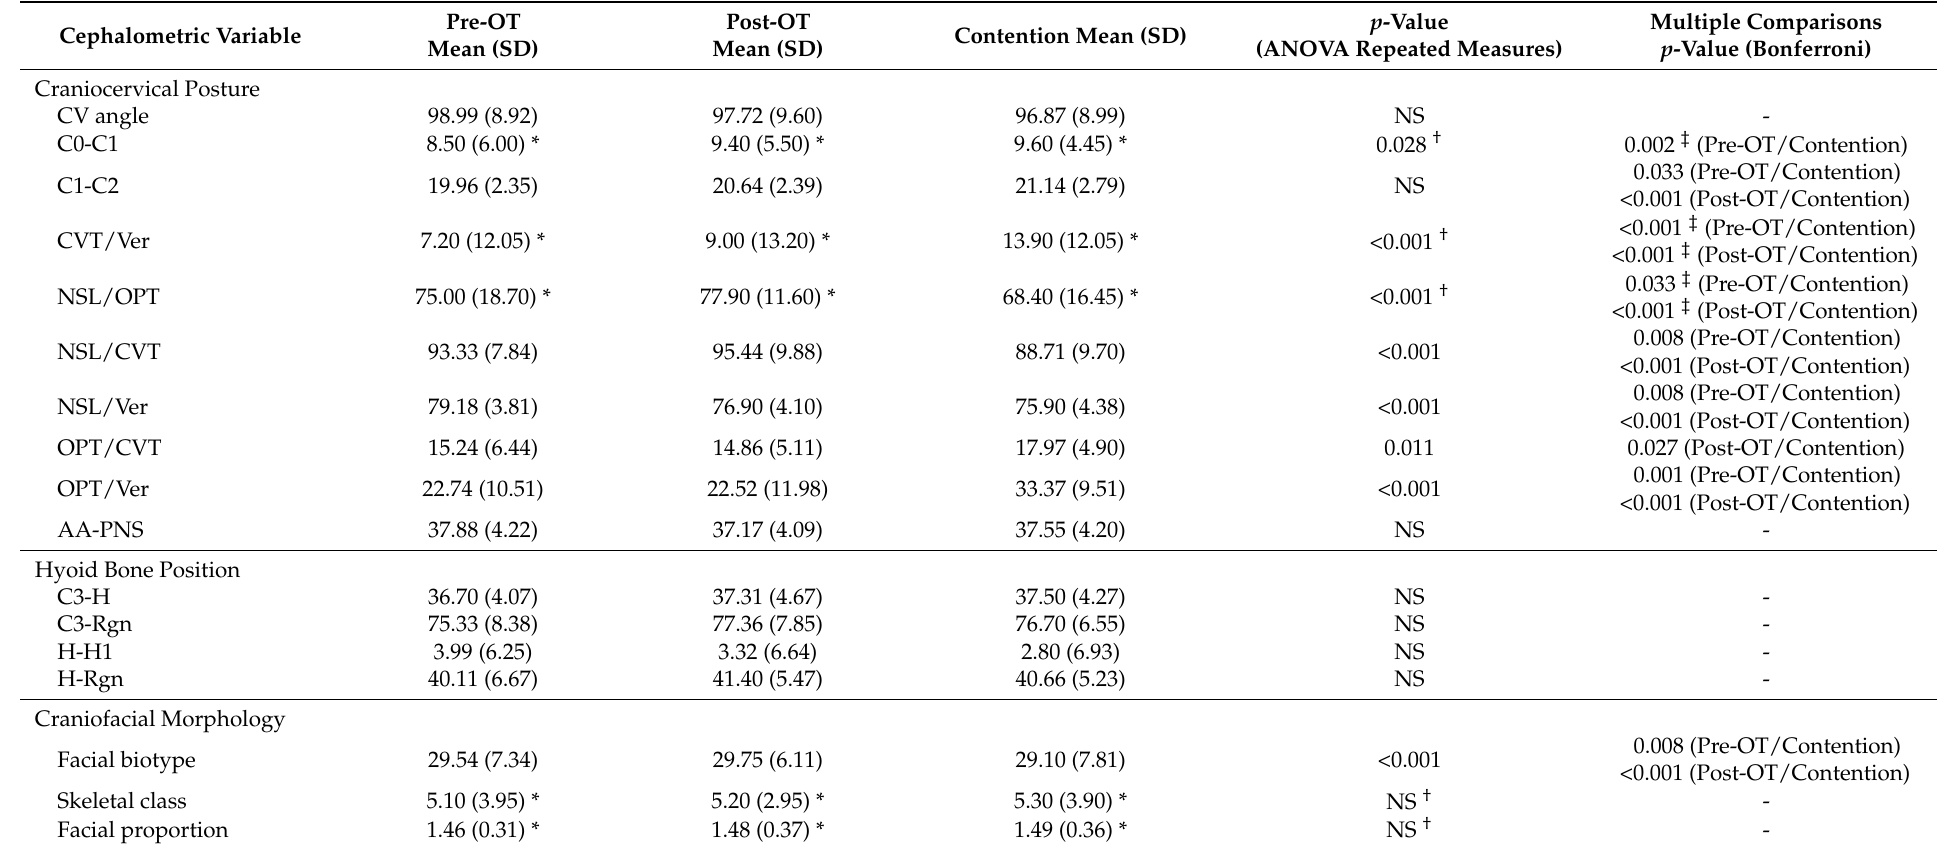
Table 4. Cephalometric variables at three moments: pre-orthodontic treatment (Pre-OT), post-orthodontic treatment (Post-OT), and contention ( n = 26), and respective p